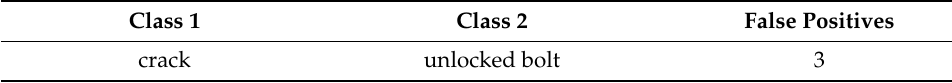
Table 11. False positives for damage diagnosis (model 1).